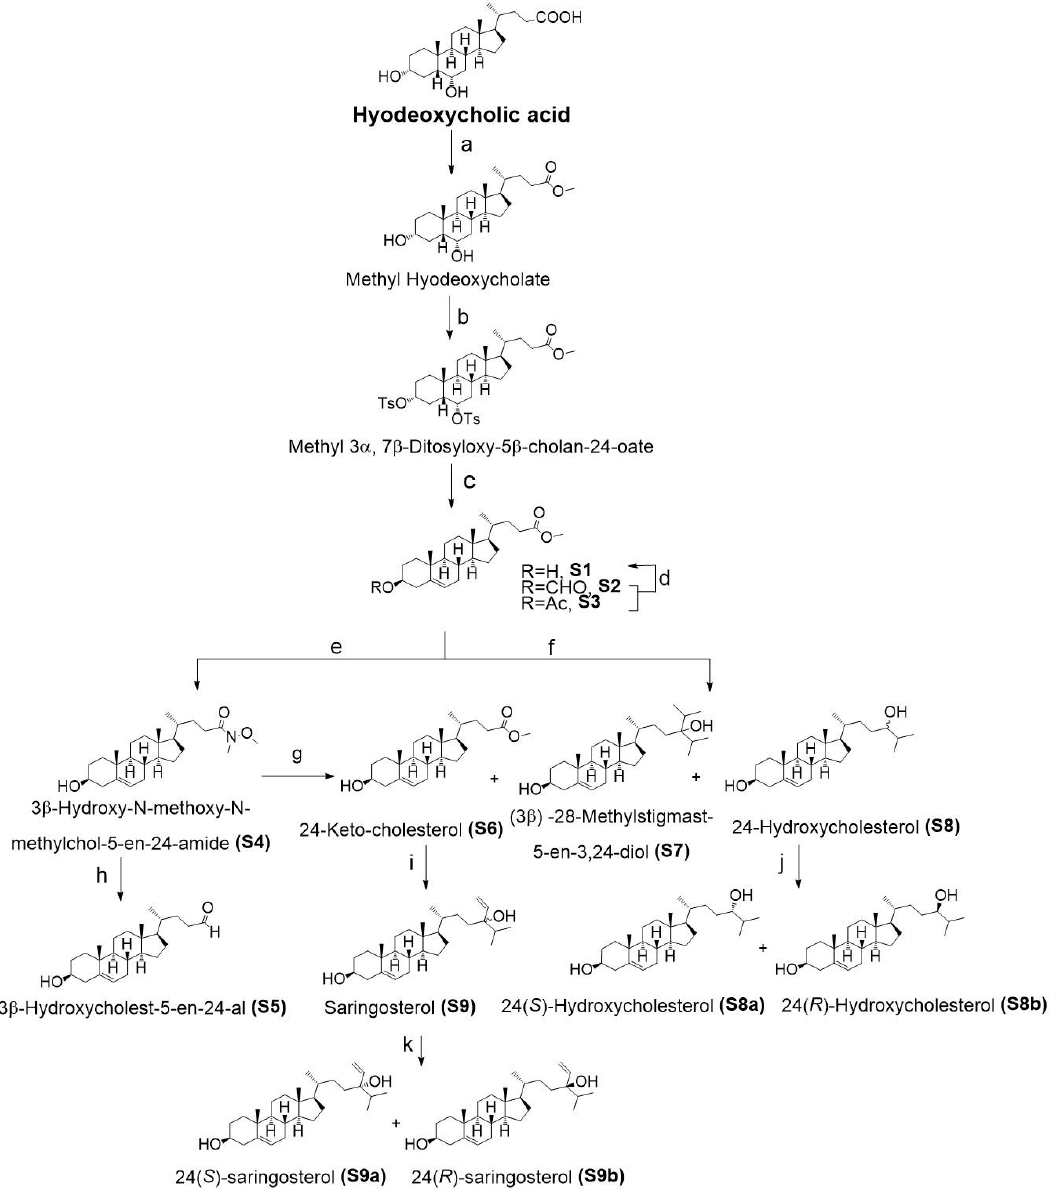
Figure 8. Synthesis of oxidized sterols, reagents and conditions: ( a ) CH 3 OH, H 2 SO 4 , 8 h, 95 °C, 89.0%; ( b ) TsCl, pyridine (Py), 24 h, room temperature (r.t)., 77.9%; ( c ) AcOK, DMF, H 2 O, 7 h, 105 °C, S1 50.9%, S2 4.2%, S3 4.5%; ( d ) 2% KOH-CH 3 OH, 3 h, r.t., 96.7%. ( e ) Isopropylmagnesium chloride solution, N,O-dimethylhydroxylamine hydrochloride, tetrahydrofuran(THF), 12 h, 0 °C-r.t., S4 85.5%; ( f ) Isopropylmagnesium bromide solution, triethylamine (Et3N), THF, 18 h, 0 °C-r.t., S6 26.8%, S7 2.8%, S8 8.2%; ( g ) Isopropylmagnesium chloride solution, THF, 18 h, 0 °C - r.t., S6 52.0%;